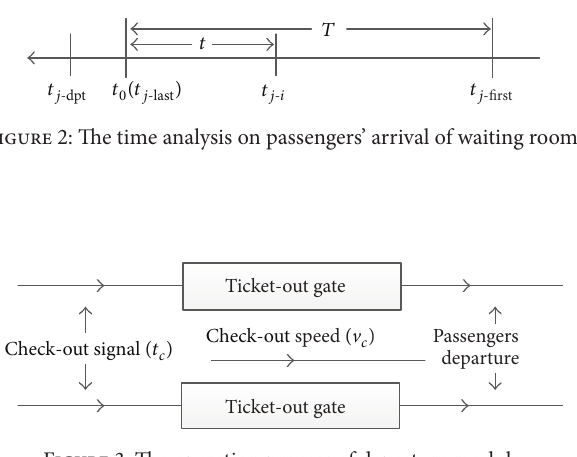
Figure 3: The operation process of departure